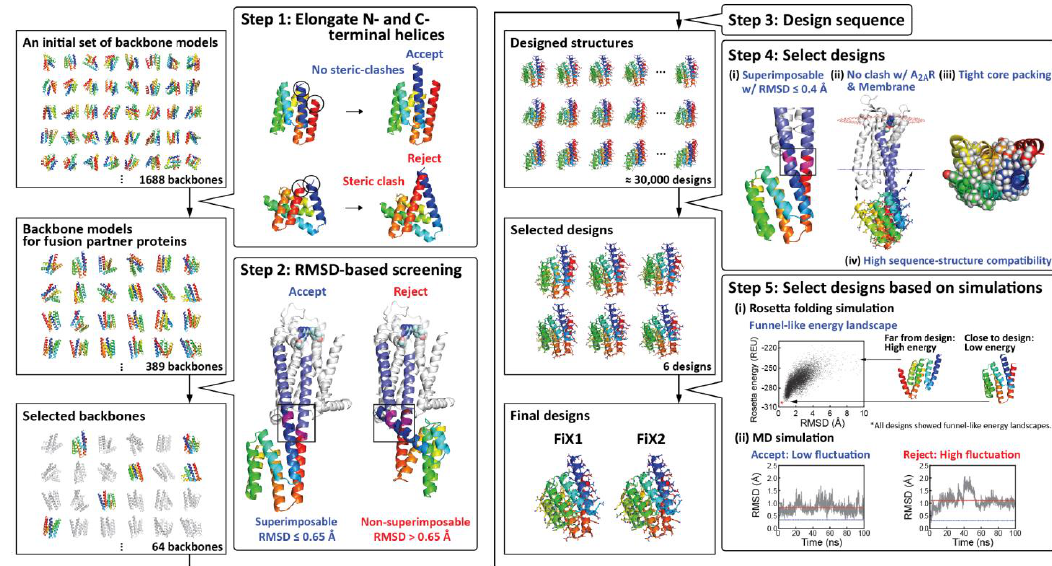
Figure 2. Computational protocol for designing fusion partner proteins. As an initial set of backbone structures, 1688 globular all- α backbone structures with six helices, extracted from the previously created all- α backbone structure library [20], were used. ( Step 1 ) For the initial set, the N- and C- terminal helices of the structures were elongated to fuse into A 2A R through TM5 and TM6. Then, 389 backbone structures whose helices were elongated without steric clash were se- lected. ( Step 2 ) Backbone structures whose elongated N- and C- terminal helices were well-superimposable (the main- chain root mean square deviation (RMSD) for the fused region, equal to or less than 0.65 Å ) to TM5 and TM6 of the inactive state A 2A R structure were selected. ( Step 3 ) For each selected backbone structure, amino acid sequences that stabilize the backbone structure were designed. ( Step 4 ) Six designed structures were selected on the basis of the following criteria: the designs are superimposable to A 2A R with main-chain RMSD values less than and equal to 0.4 Å for the fused region, have tight core packing [27] and high sequence-structure compatibility [17] and can be fused into A 2A R without steric crash with A 2A R and the membrane. ( Step 5 ) Two designed proteins that exhibited funnel-shaped energy landscapes in Rosetta fold- ing simulations [17] and whose N- and C- terminal helices show low fluctuation in molecular dynamics (MD) simulations were selected. In the MD simulations, blue and red lines show initial and averaged main-chain RMSD values, respectively. Details are described in the Results and Materials and Methods. 2.2. Experimental Characterization of FiX1 and FiX2 We experimentally characterized the de novo designed proteins, FiX1 and FiX2, with- out A 2A R. These two designs were expressed in Escherichia coli and purified using a Ni- NTA column. Both of the designs were found to be well expressed and highly soluble, and are then characterized via circular dichroism (CD) spectroscopy, size-exclusion chro- matography combined with multi-angle light scattering (SEC-MALS), and 1 H – 15 N hetero- nuclear single quantum coherence (HSQC) nuclear magnetic resonance (NMR) spectros- copy (Figure 3). Both designs showed CD spectra of all- α proteins from 25 to 98 °C, were monomeric in SEC-MALS, and showed well-dispersed sharp NMR peaks. These results indicate that the designs fold into unique α -helical structures as monomers with high ther- mal stability.